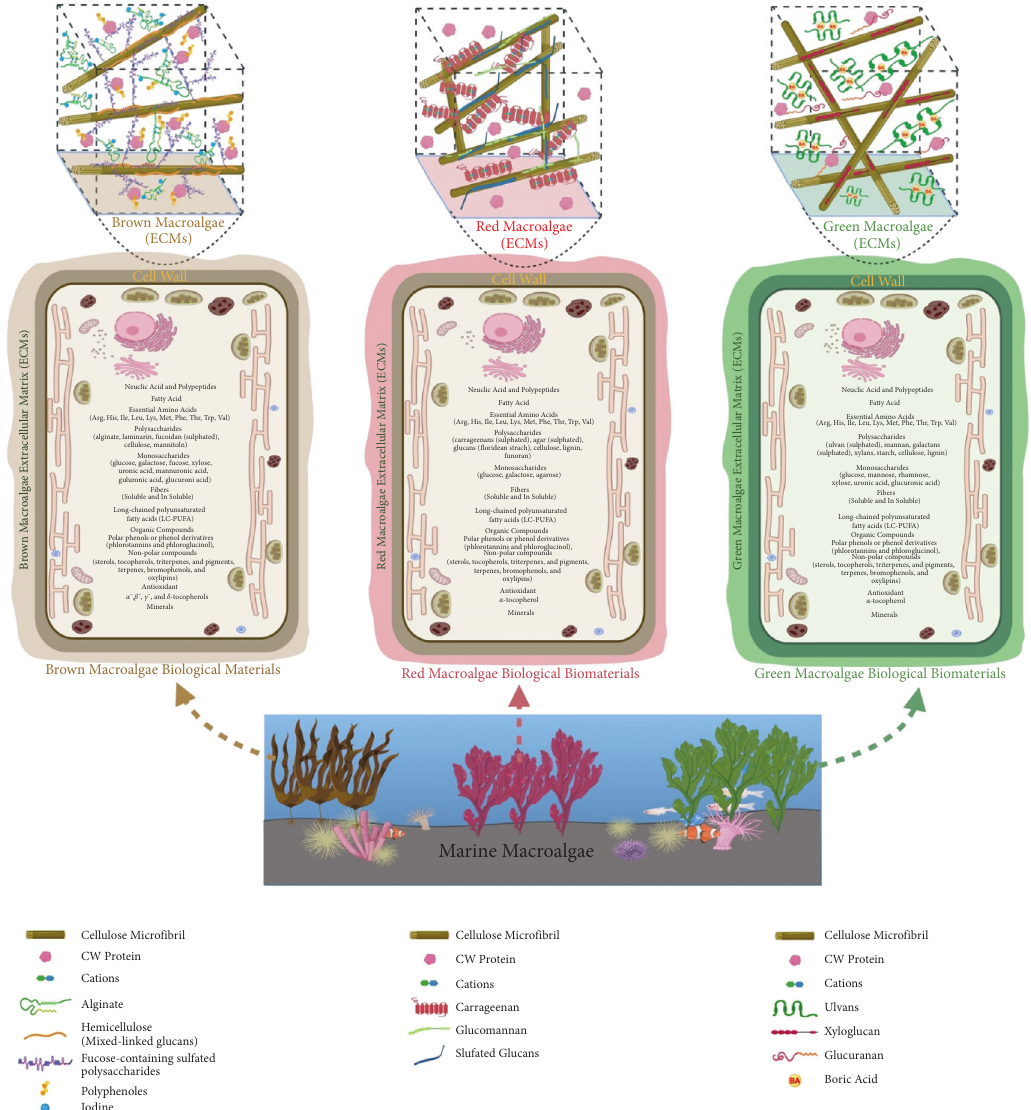
Figure 4: Illustration showing variations in extracellular matrix (ECMs) of marine macroalgae (brown, red, and green) and differences in their intracellular biological materials. The figures of marine macroalgae ECMs were adopted from the review of Kloareg et al. [89] and redrawn from the work of Deniaud-Bou¨et and coworkers [90], as well as updated from the following references for brown macroalgae [91–93], red macroalgae [94–96], and green macroalgae [97]. CW Protein (cell wall protein). Created with BioRender.com with publication